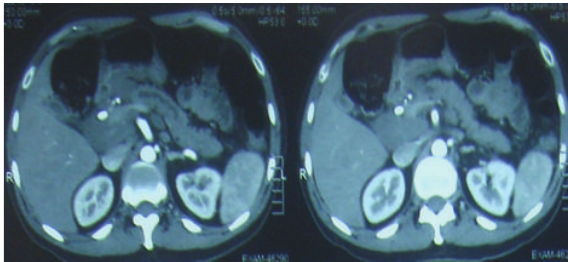
Figure 3: Six months after initial presentation. Persistent enlarge- ment of peripancreatic lymph nodes and pancreatic duct